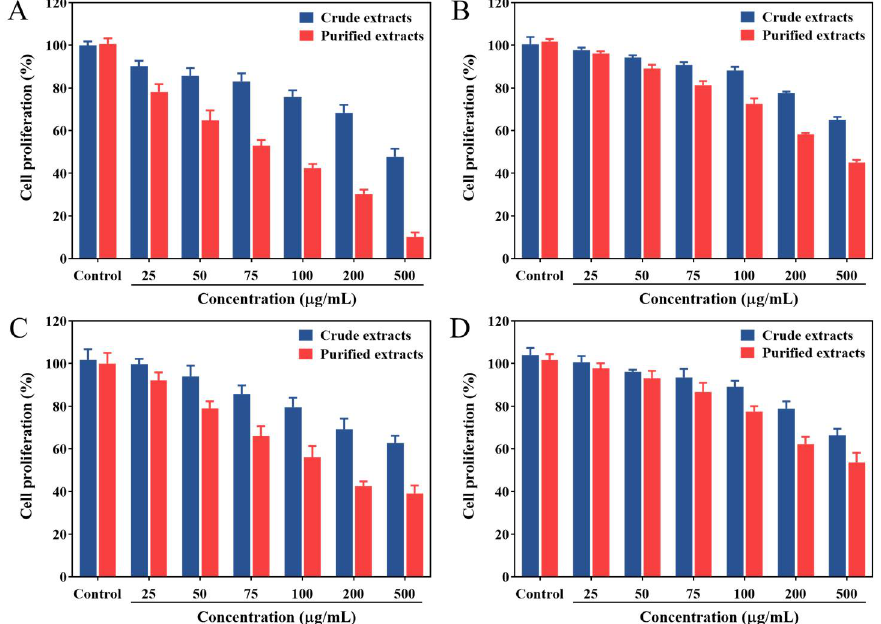
Figure 5. Antiproliferative activities of crude extracts and purified extracts from Rosa setate x Rosa rugosa waste against HepG-2 ( A ), MCF-7 ( B ), Caco-2 ( C ) and A549 ( D ) cell